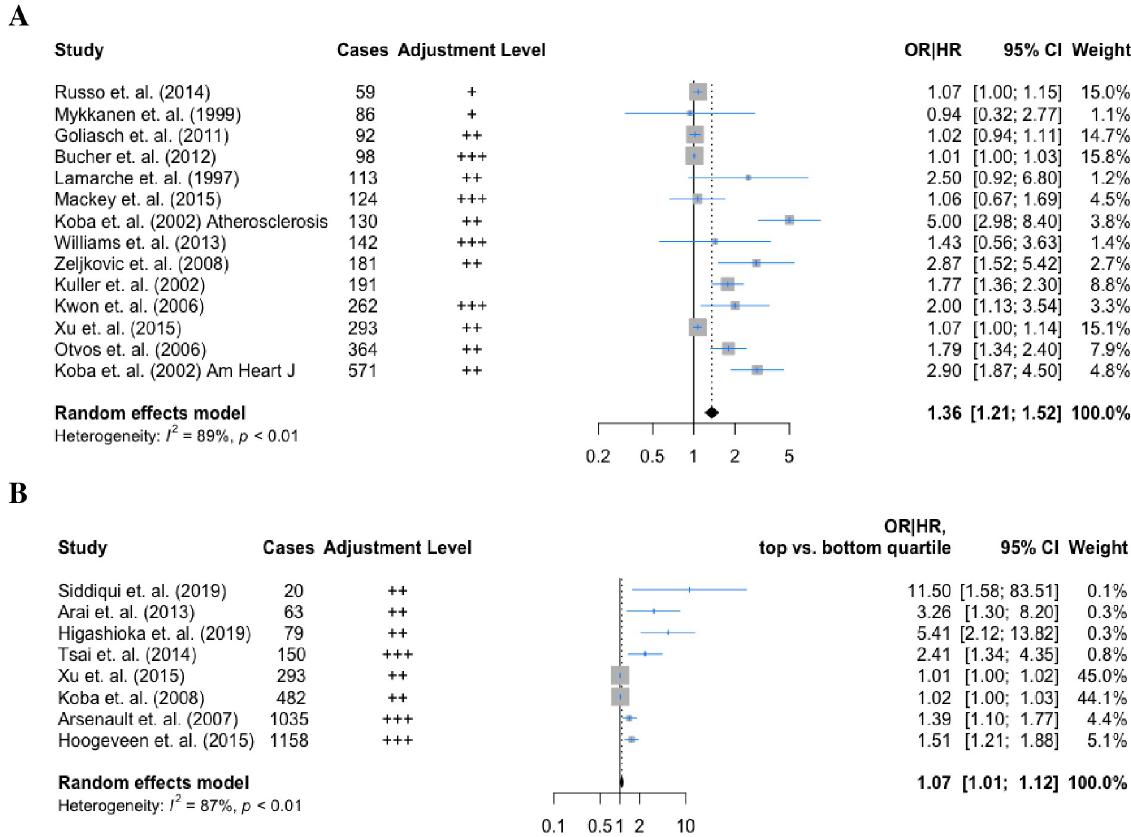
Fig 2. Forest plots for random effects meta-analysis of the associations between (A) sdLDL, (B) sdLDL-C and CHD. ‘+’ = adjusted for other lipid subfractions; ‘++’ = adjusted for demographics and lifestyle risk factors; ‘+++’ = adjusted for demographics, lifestyle risk factors and lipid subfractions. Maximally adjusted hazard ratios from each study were used. Kuller et. al. provided an unadjusted estimate only.